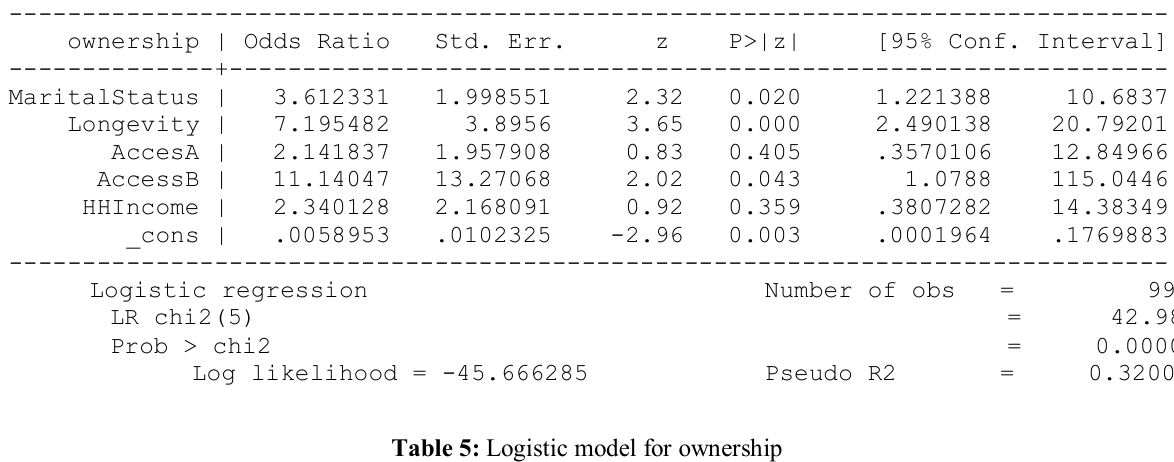
Table 5: Logistic model for ownership